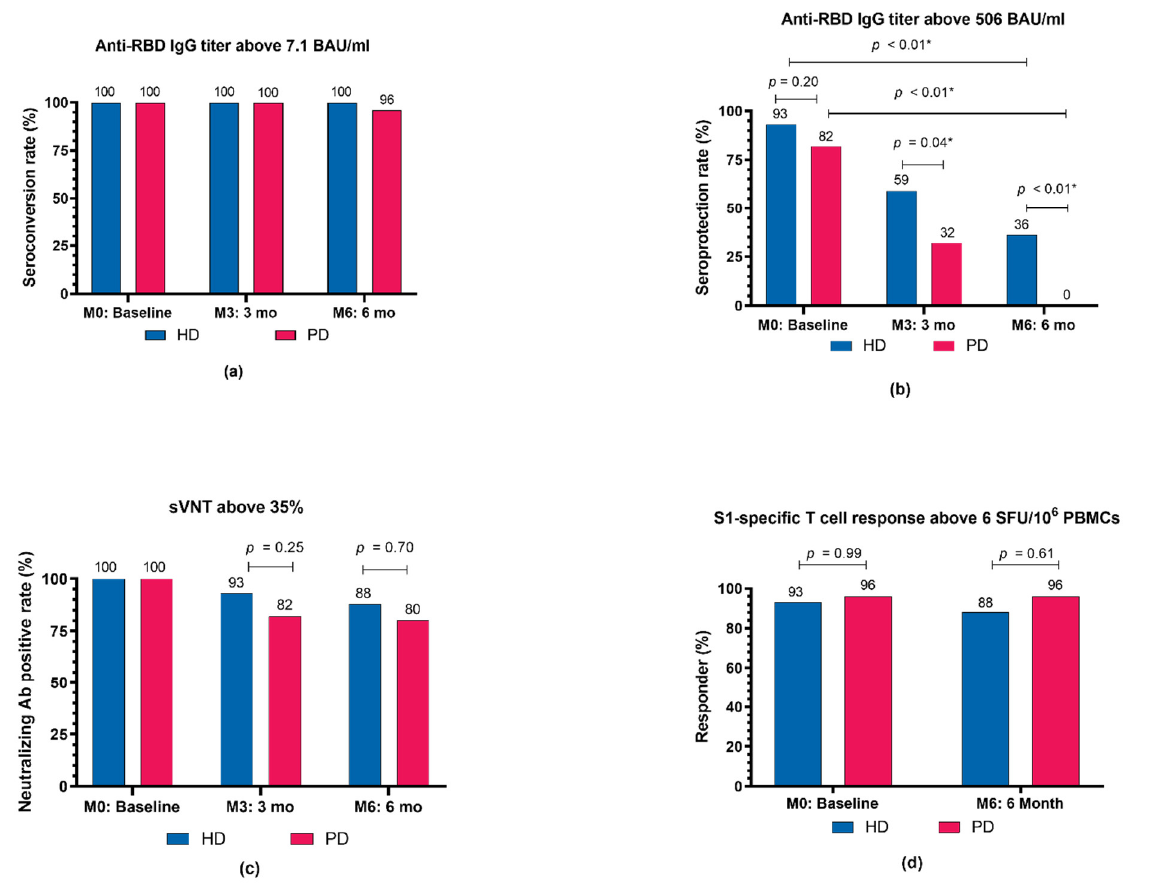
Figure 3. Proportions of dialysis patients who achieved specific immunogenicity thresholds following COVID-19 vaccination with an extended primary series, composed of a heterologous inactivated SARS-CoV-2 prime-boost and ChAdOx1 nCoV-19 vaccine as the third dose, at 2 weeks (M0), 3 months (M3), and 6 months (M6) after the completion of vaccination. ( a ) Proportions of patients who met the seroconversion threshold (anti-RBD IgG titer of ≥ 7.1 BAU/mL). ( b ) Proportions of patients who met the seroprotection threshold against the SARS-CoV-2 Alpha (B.1.1.7) variant (anti-RBD IgG titer of ≥ 506 BAU/mL). ( c ) Proportions of patients who met the threshold of neutralizing antibody positive (percent inhibition of >35%). ( d ) Proportions of patients who met the criteria for a S1-specific T-cell responder (IFN- γ -producing T-cell response to the S1 scanning peptide pool of >6 SFU/10 6 PBMCs). Ab, antibody; BAU, binding antibody units; HD, hemodialyzed patients; IgG, immunoglobulin G; PBMCs, peripheral blood mononuclear cells; PD, peritoneal dialyzed patients; RBD, receptor-binding domain; S1, S1 domain of the spike protein; SFU, spot-forming unit; sVNT, surrogate virus neutralization test; * p < 0.05.